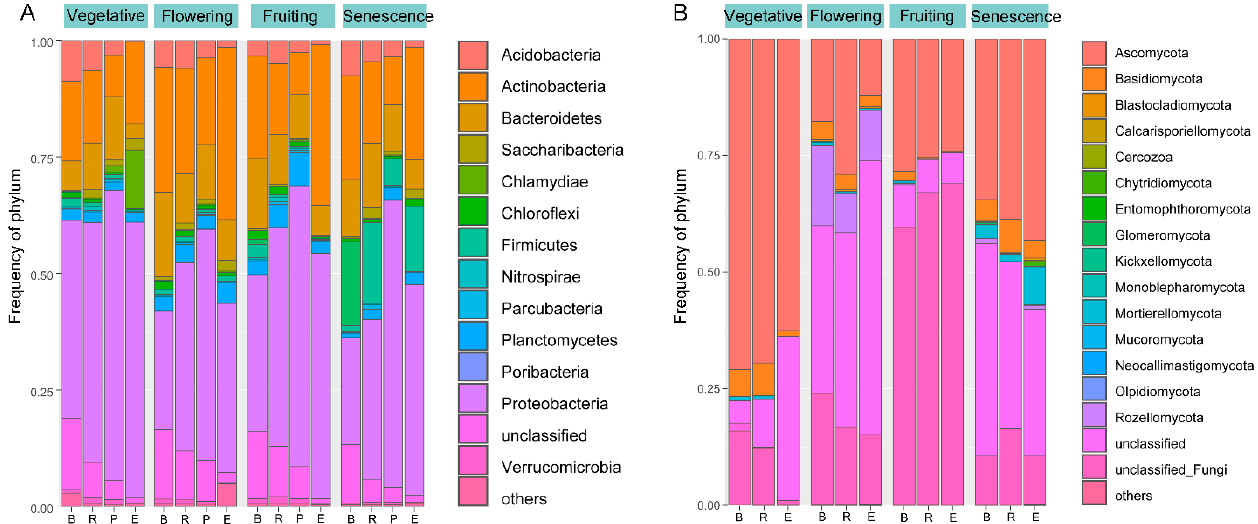
Figure 2. Histograms of the phyla abundances in bacterial community ( A ) and fungal community ( B ). R, rhizosphere; P, rhizoplane; E, endosphere; B, bulk soil; unclassified, has no assignment of affiliation at the relevant taxonomic level.